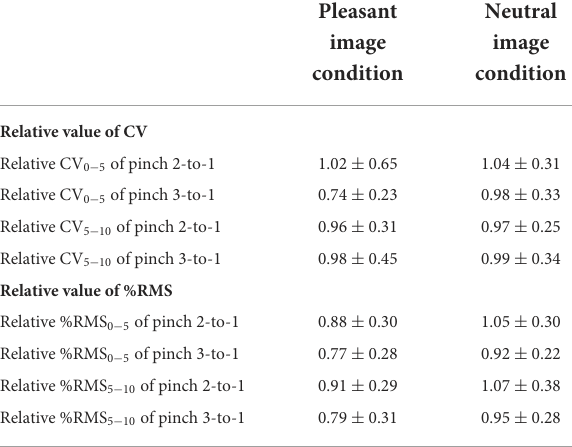
Regarding the neutral image condition, CV 5 − 10 values for both the pinch1 and 2 trials were significantly lower than the CV 0 − 5 values (Pinch 1 trial: Wilcoxon signed-rank test, t = 4.11, 95% CI = 0.466 to 1.47, p < 0.001, r = 0.728, Figure 4). As observed in pleasant image condition, there was no difference between CV 5 − 10 and CV 0 − 5 values for the Pinch 3 trial (Wilcoxon signed-rank test, Z = − 1.55, p = 0.121, r = 0.274, Figure 4). There were no differences between %RMS 5 − 10 and %RMS 0 − 5 values for all pinch tasks under the pleasant image condition (Pinch 1 trial: Paired t -test, t = − 0.391, df = 15,